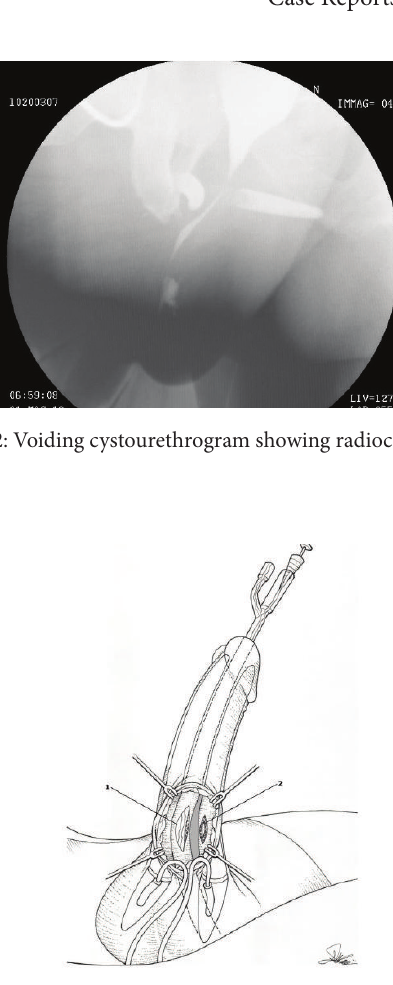
Figure 3: Urethral (1) and left corpus cavernosum (2) defects after fistula